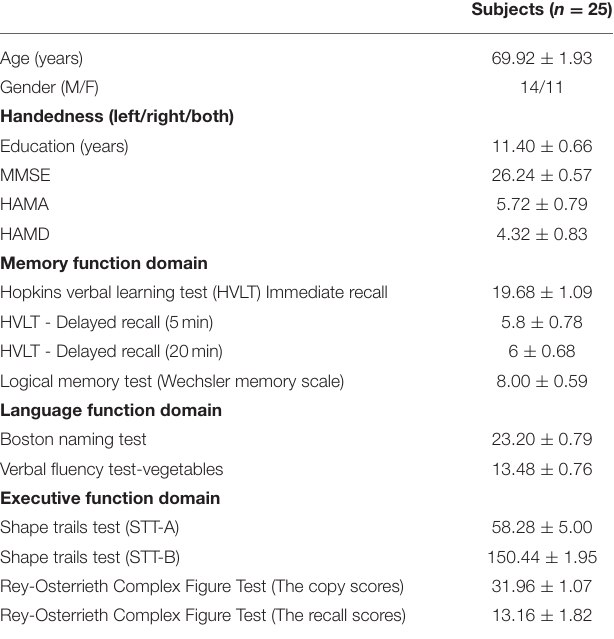
TABLE 1 | Demographic